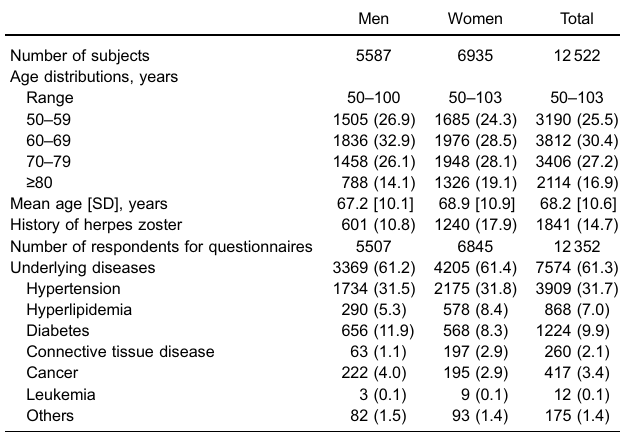
Table 1. Baseline characteristics of participants